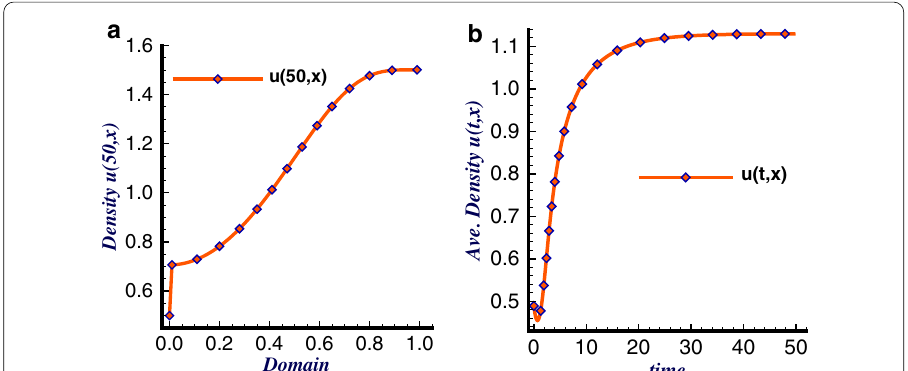
50 and b average solutions of (11) with respect to time = 1.0 on � ( 0,1 ) , with u 0 = =